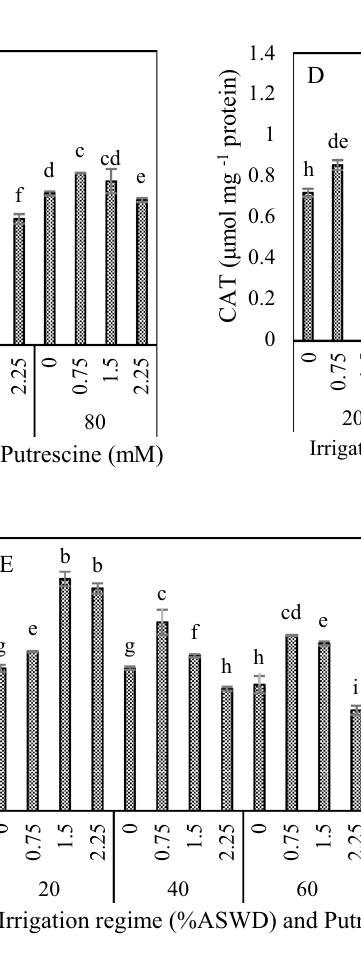
Figure 5. Interaction between irrigation regime and putrescine on SOD ( A ), PO ( B ), APX ( C ), CAT ( D ) and DPPH ( E ). The different letters show significantly different at the level of 0.01. The error bars represent standard